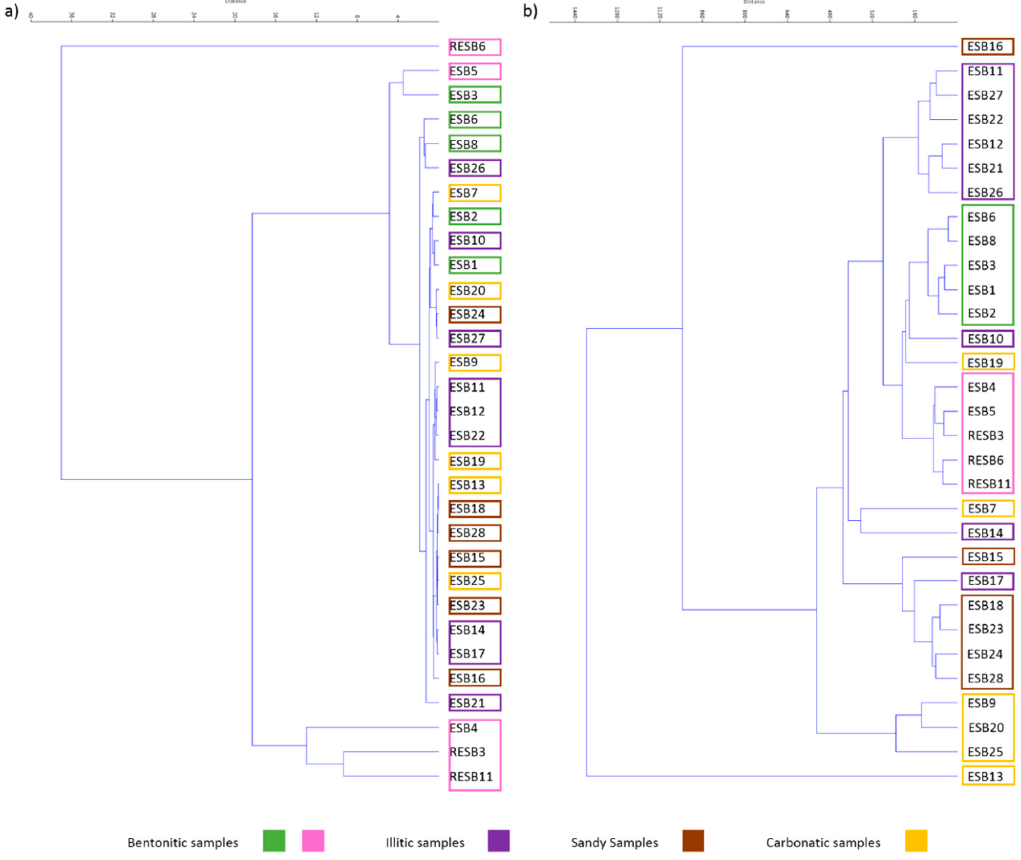
Figure 11. ( a ) Multivariate cluster of the biomarkers’ content; ( b ) multivariate cluster of the biomarker plus geochemical contents.